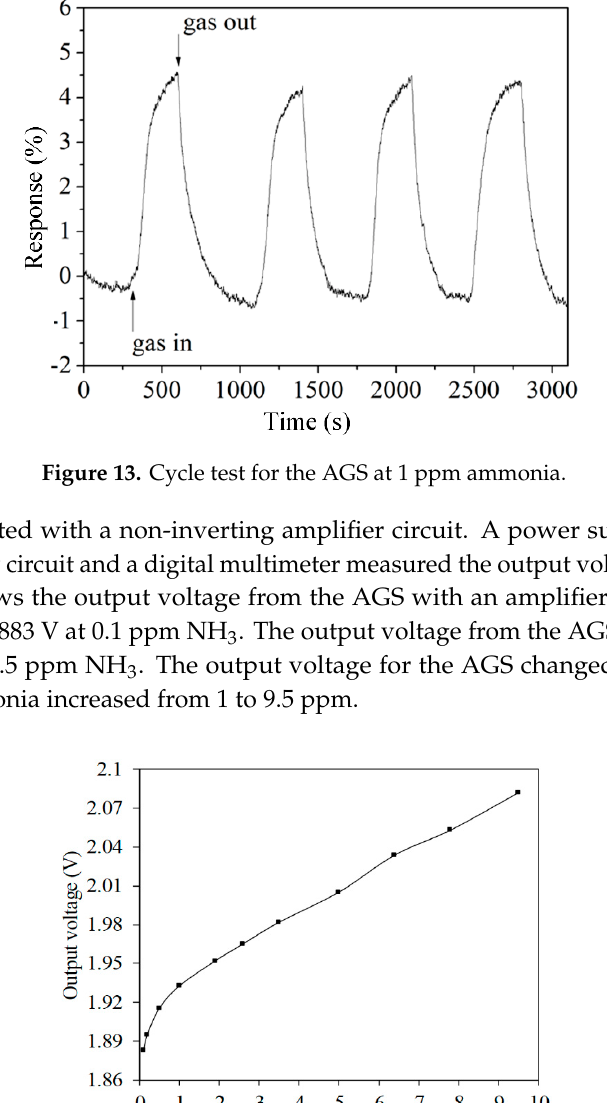
Figure 12. Response of the AGS.